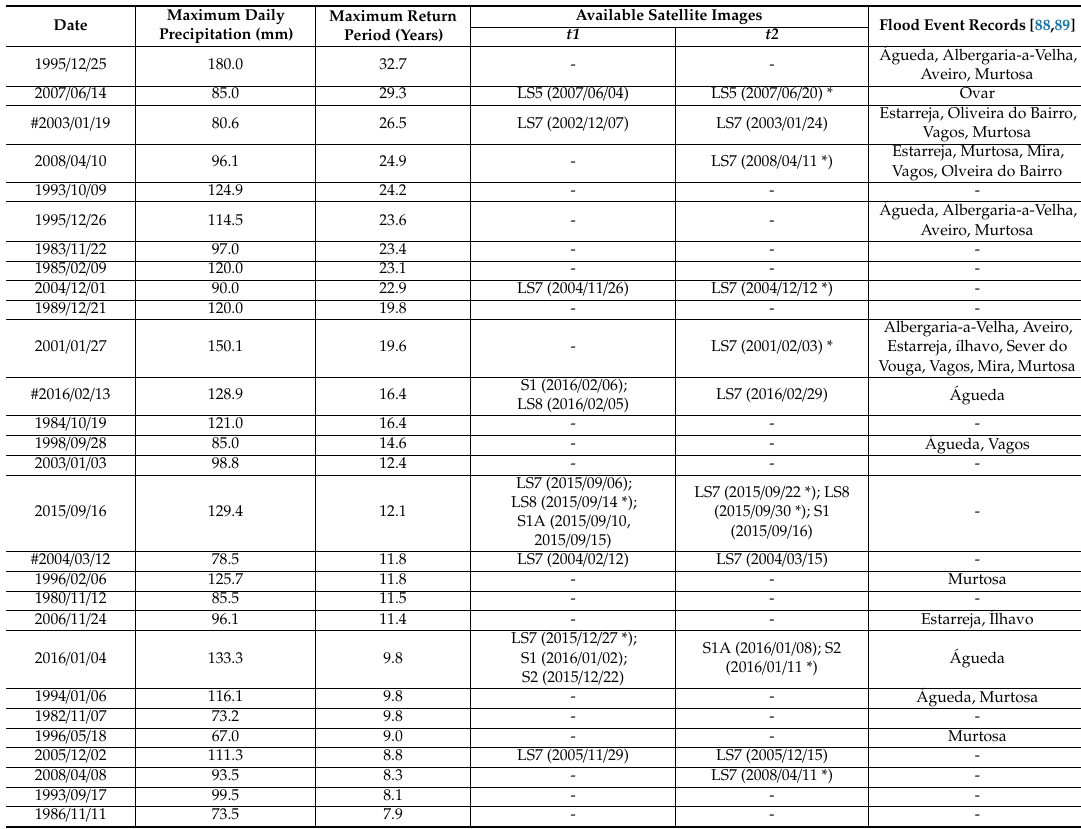
Table A1. Fifty largest precipitation events, from 23 meteorological stations located in the Vouga River watershed (between 1979 / 12 / 30 and 2017 / 09 / 12); Corresponding availability of satellite images: LS—Landsat; S—Sentinel; This table is ordered according to the maximum return period (descending). Maximum Daily Available Satellite Images FloodEventRecords[88,89] Maximum Return Precipitation (mm) Period (Years)